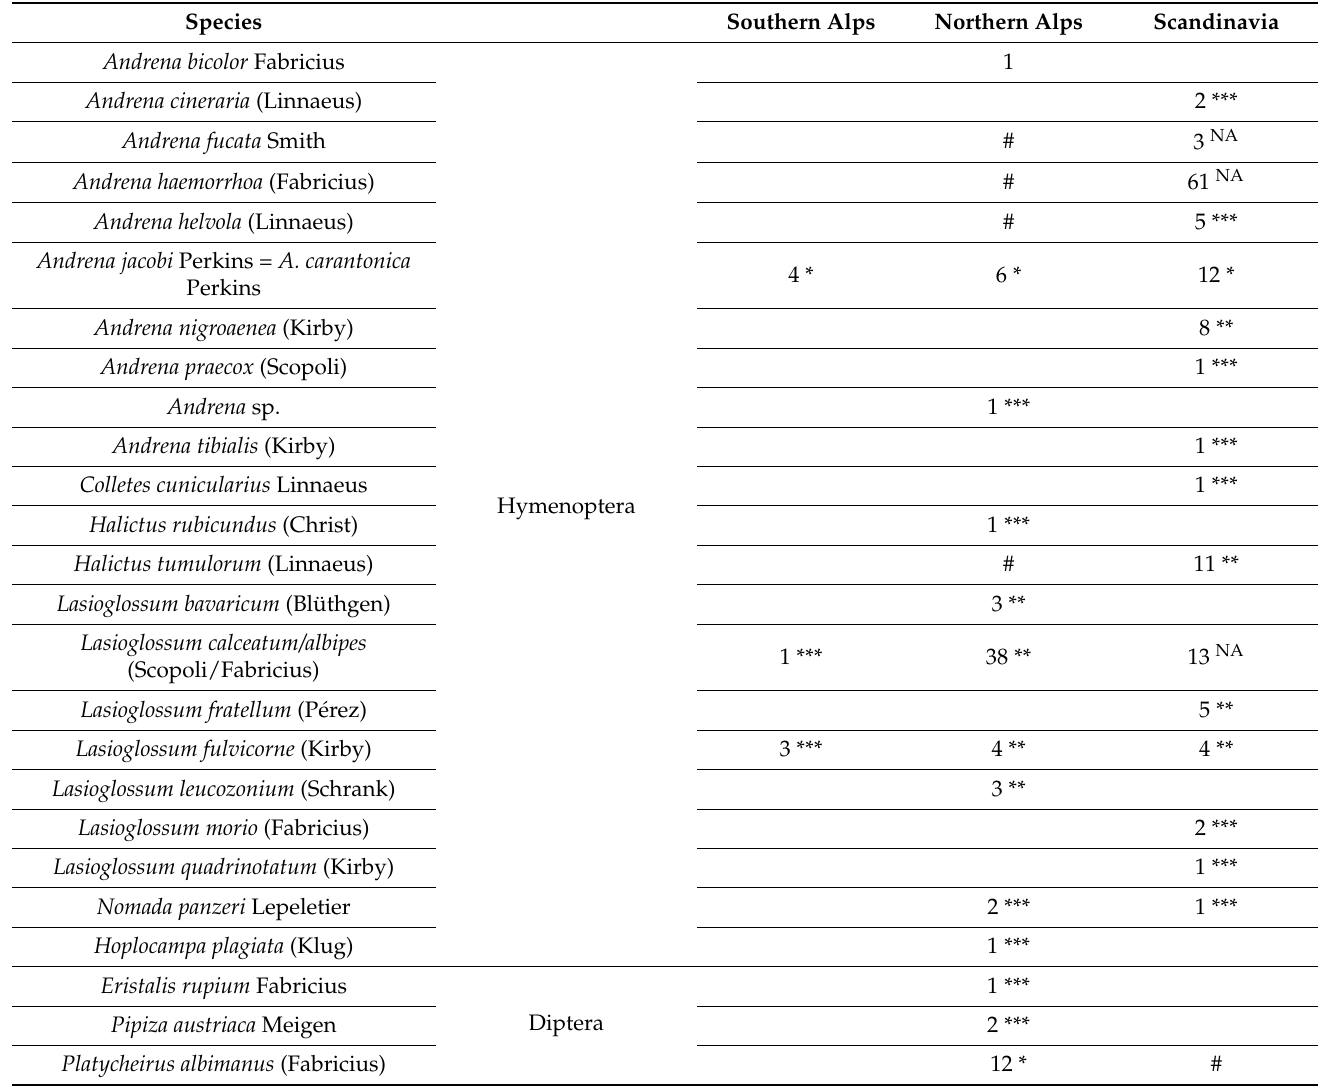
Table 2. Pollinators of Cypripedium calceolus were observed at the three regions. with the numbers of individuals per species observed. Data from the Northern Alps were from Braunschmid et al. [12], those from Scandinavia from Nilsson [21], Erneberg and Holm [23], and Antonelli et al.